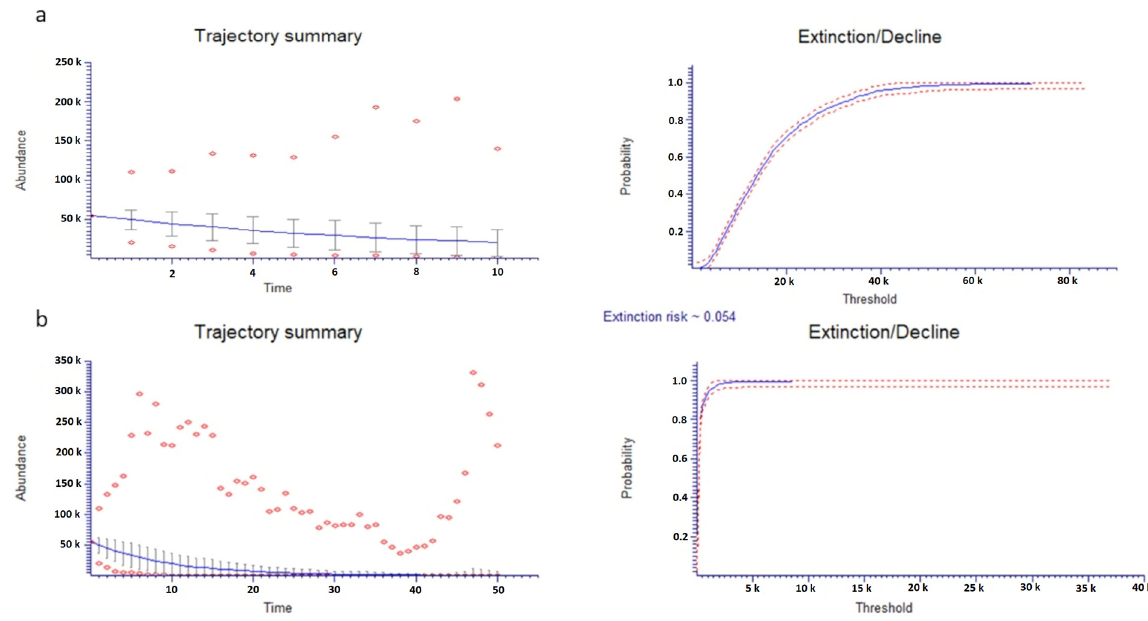
Figure 4. Population viability analysis of Micromeria browiczii over ( a ) the next 10 and ( b ) the next 50 years. The average (line), ± 1 standard deviation and minimum and maximum (dots) numbers of the population of M. browiczii are